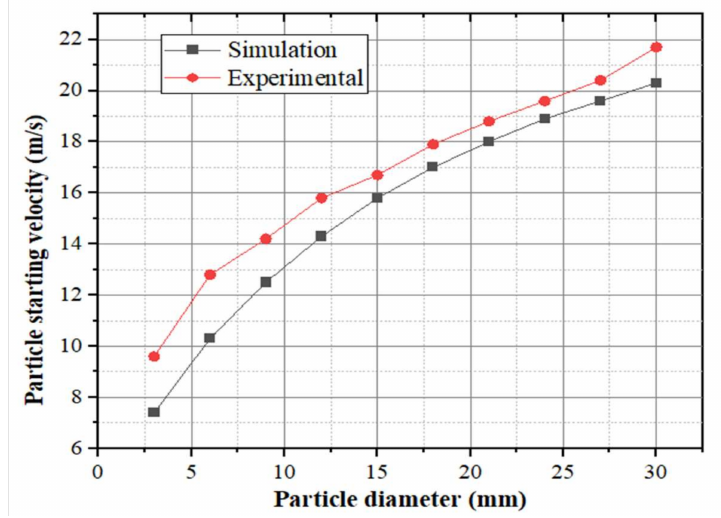
Figure 5. The simulation and experimental results of wood particle starting velocity.